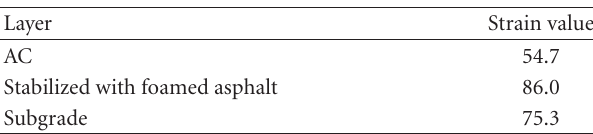
Table 3: Strain design